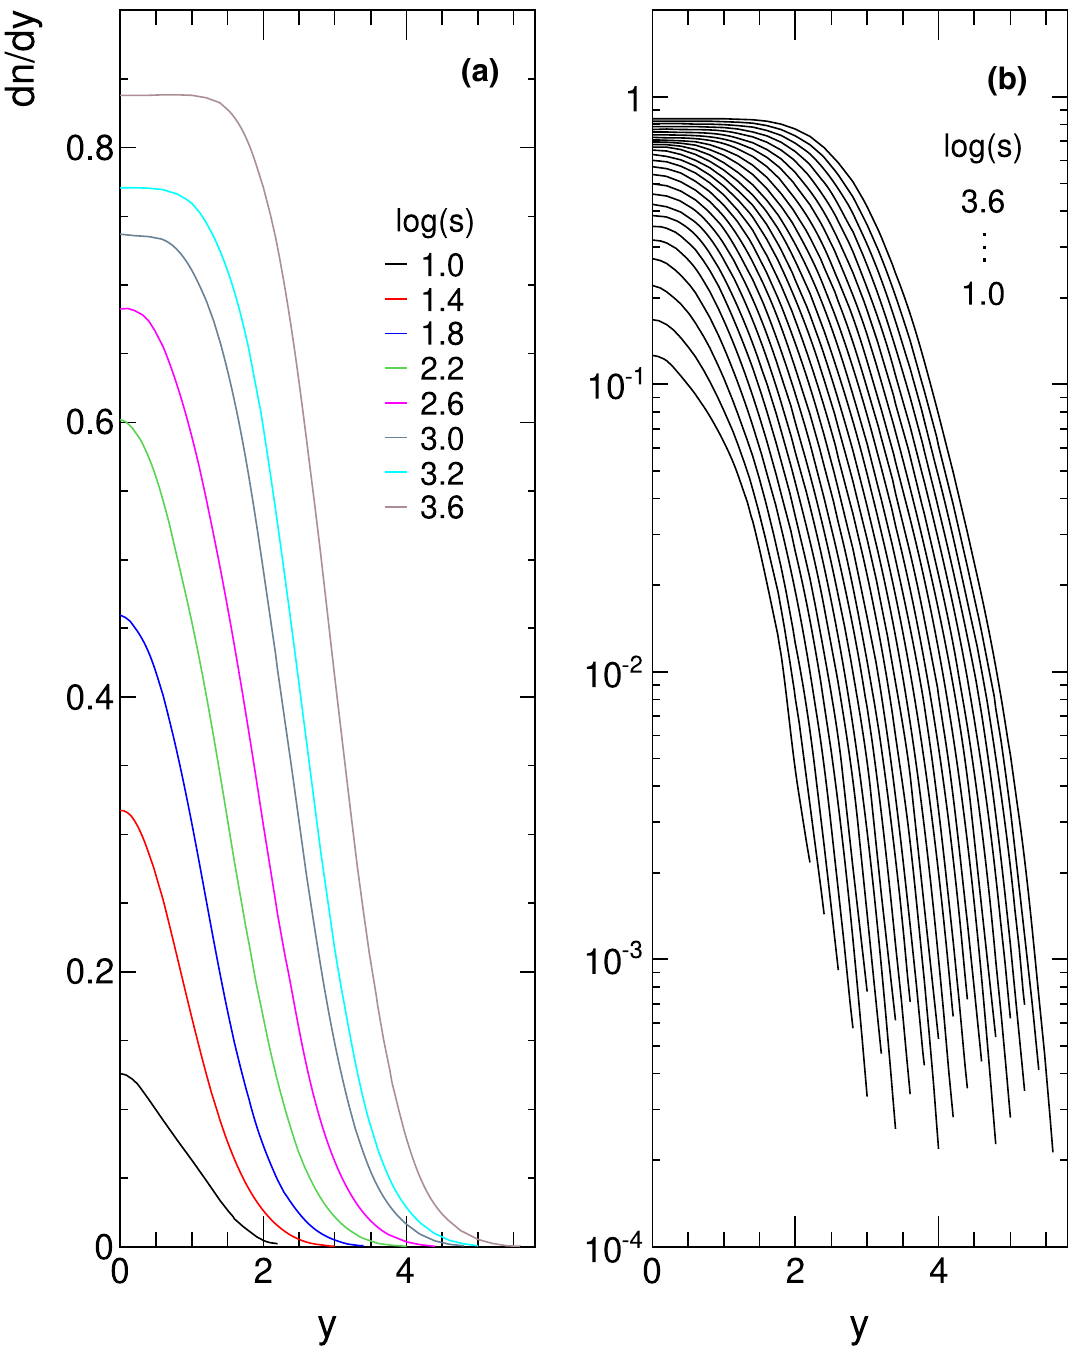
Fig. 147 dn / dy distributions as functions of y for several log ( s ) values from 1 to 3.6 using the p T integration up to 1.3 GeV/c (a) with a linear scale on the ordinate (b) with a logarithmic scale for a dense coverage in log ( s ) from 1 to 3.6 in steps of